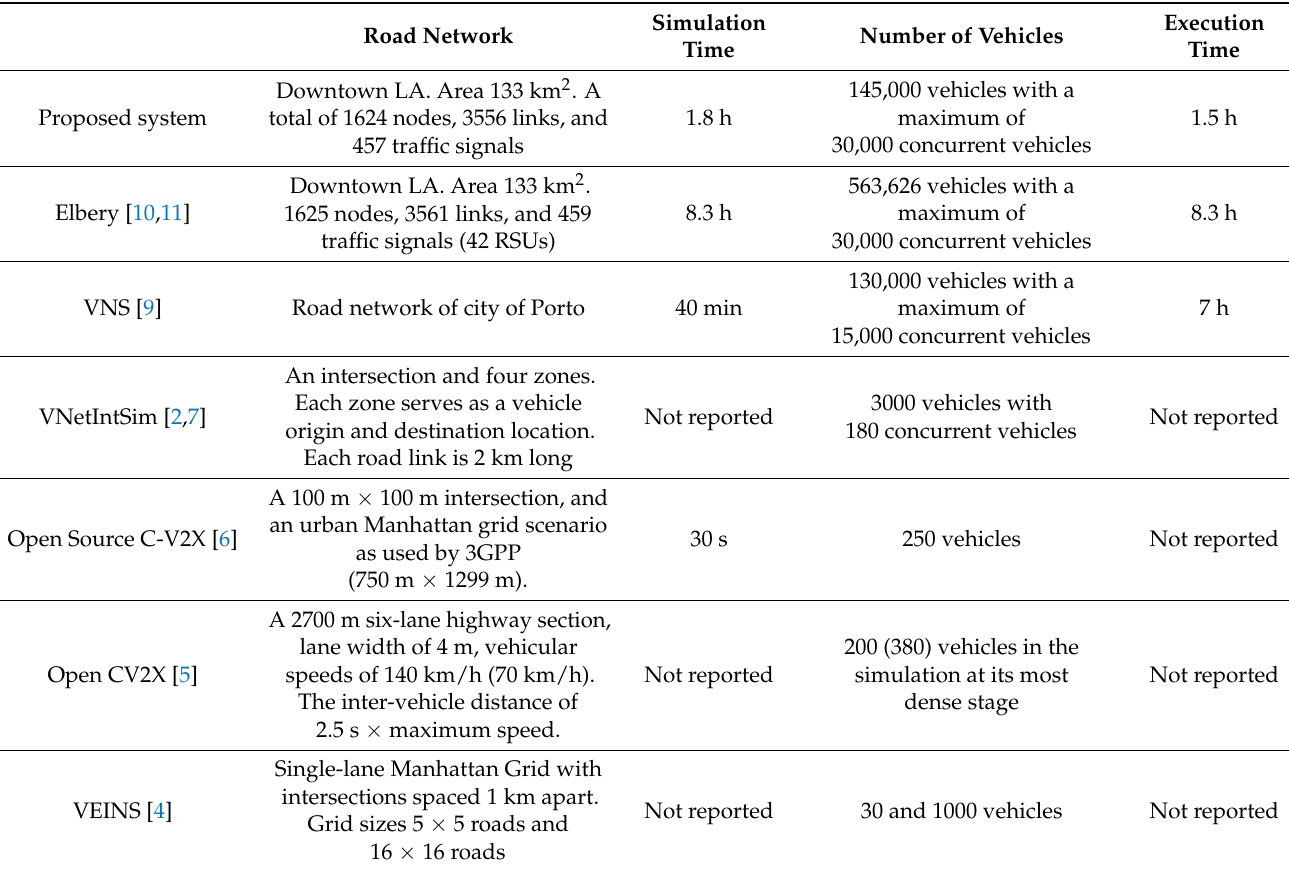
Table 2. Road Networks architecture and simulation and execution